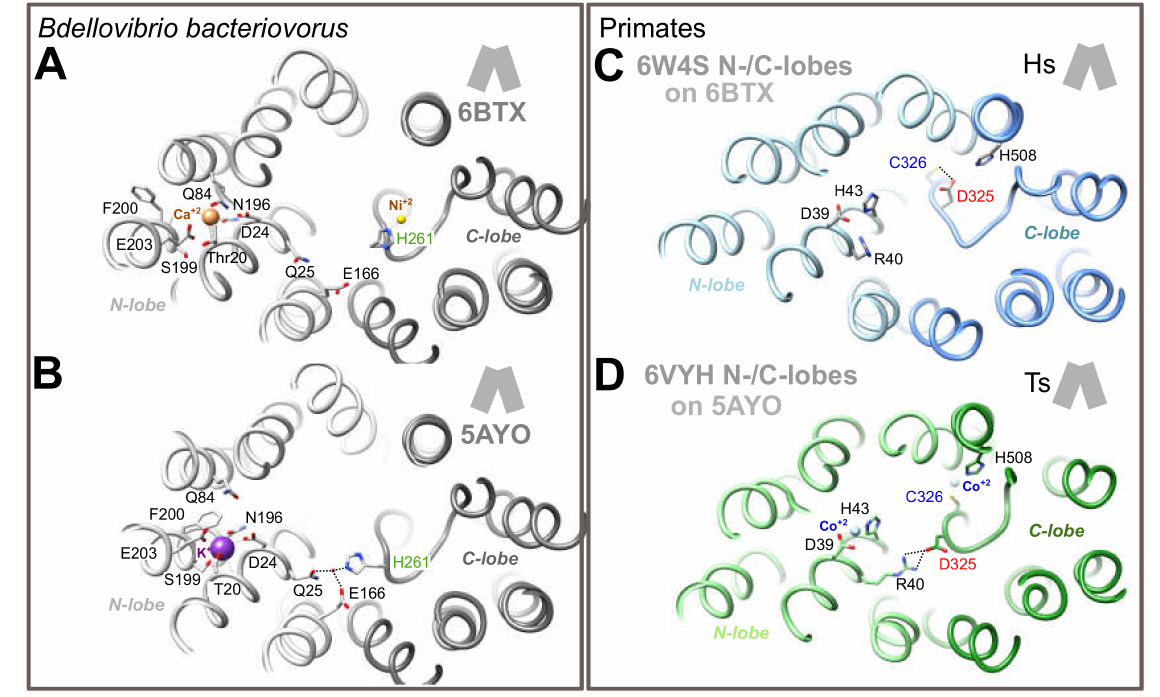
Figure 4. Predicted arrangement of the N- and C-lobes of the HsFPN1/TsFpn in an inward-facing conformation (panels C and D ), as deduced from superimposition of the N- and C-lobes of the HsFPN1/TsFpn in an outward-facing conformation onto the corresponding lobes in the 3D structures of BbFpn solved in an inward-facing conformation (panels A and B ). H-bonds and salt-bridges are shown with dashed lines. The BbFpn/TsFpn 3D structures also illustrate the position and features of the ion binding sites in the